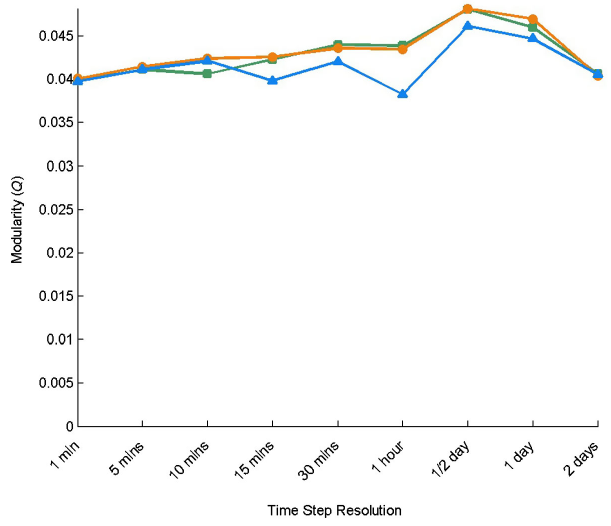
FIG. 13. Multifrequency analysis of the modularity Q 3 ð ~ σ (cid:4) Þ for the different methods, as the resolution goes from 1-min intervals to 2-day intervals. A relatively consistent value of the modularity can be seen across all time-step resolutions. (The Potts algorithm is shown by green squares, the Louvain algorithm by orange circles, and the spectral algorithm by blue triangles.)